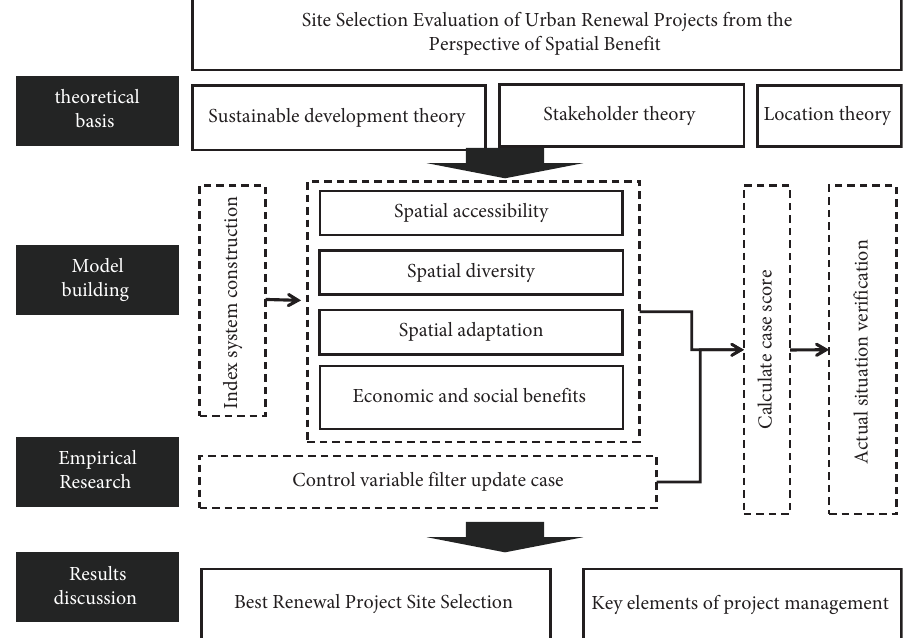
Figure 1: Te technical route of urban renewal site selection assessment (source: self-drawn by the